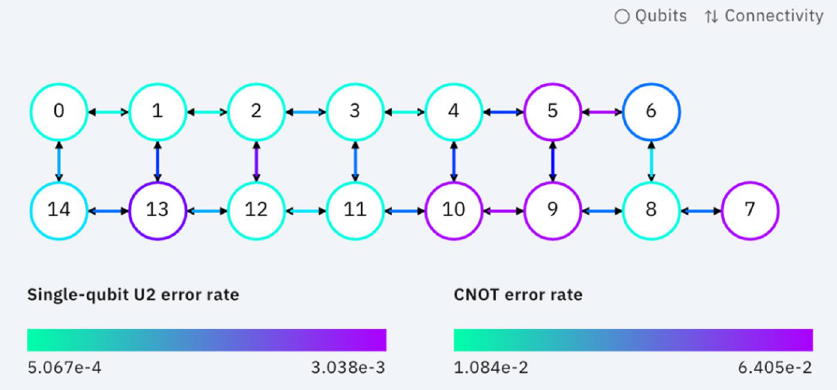
Figure 5. Topology and coupling map of the IBMQ Melbourne (https:// quant um- compu ting. ibm. com/ servi ces). Single-qubit error rate is the error induced by applying the single-qubit gates. CNOT error is the error of the only two-qubit CNOT gates. Each circle represents a physical superconducting qubit and each coupling between neighbor